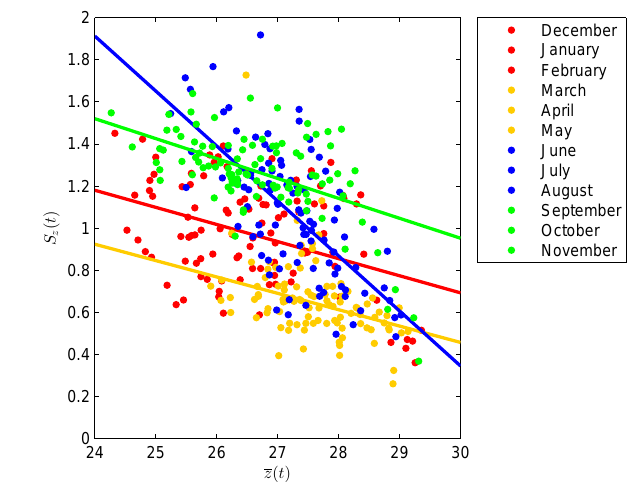
Figure 3. Spatial standard deviation, S z ( t ), vs. spatial mean, z ( t ), in the Niño 3.4 region, for all t ∈ D t , where each season has a different colour. The WTS-estimated lines for each season are superimposed (DJF line is red; MAM line is yellow; JJA line is blue; SON line is green). Units on both axes are ◦